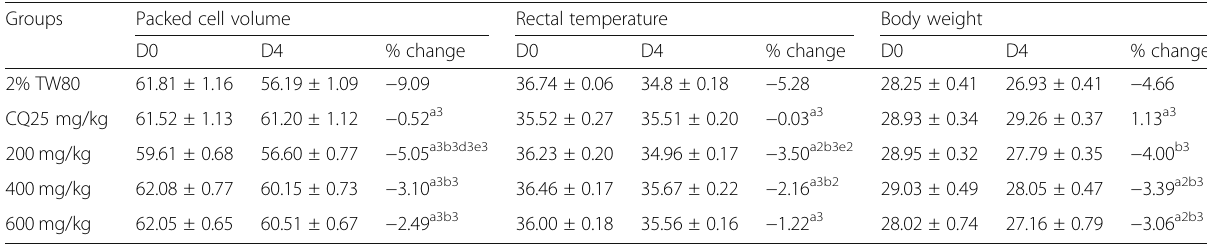
Table 2 Packed cell volume, rectal temperature and body weight of infected mice treated with 80% methanol extract of the leaves of Olea europaea in the 4-day suppressive test Groups